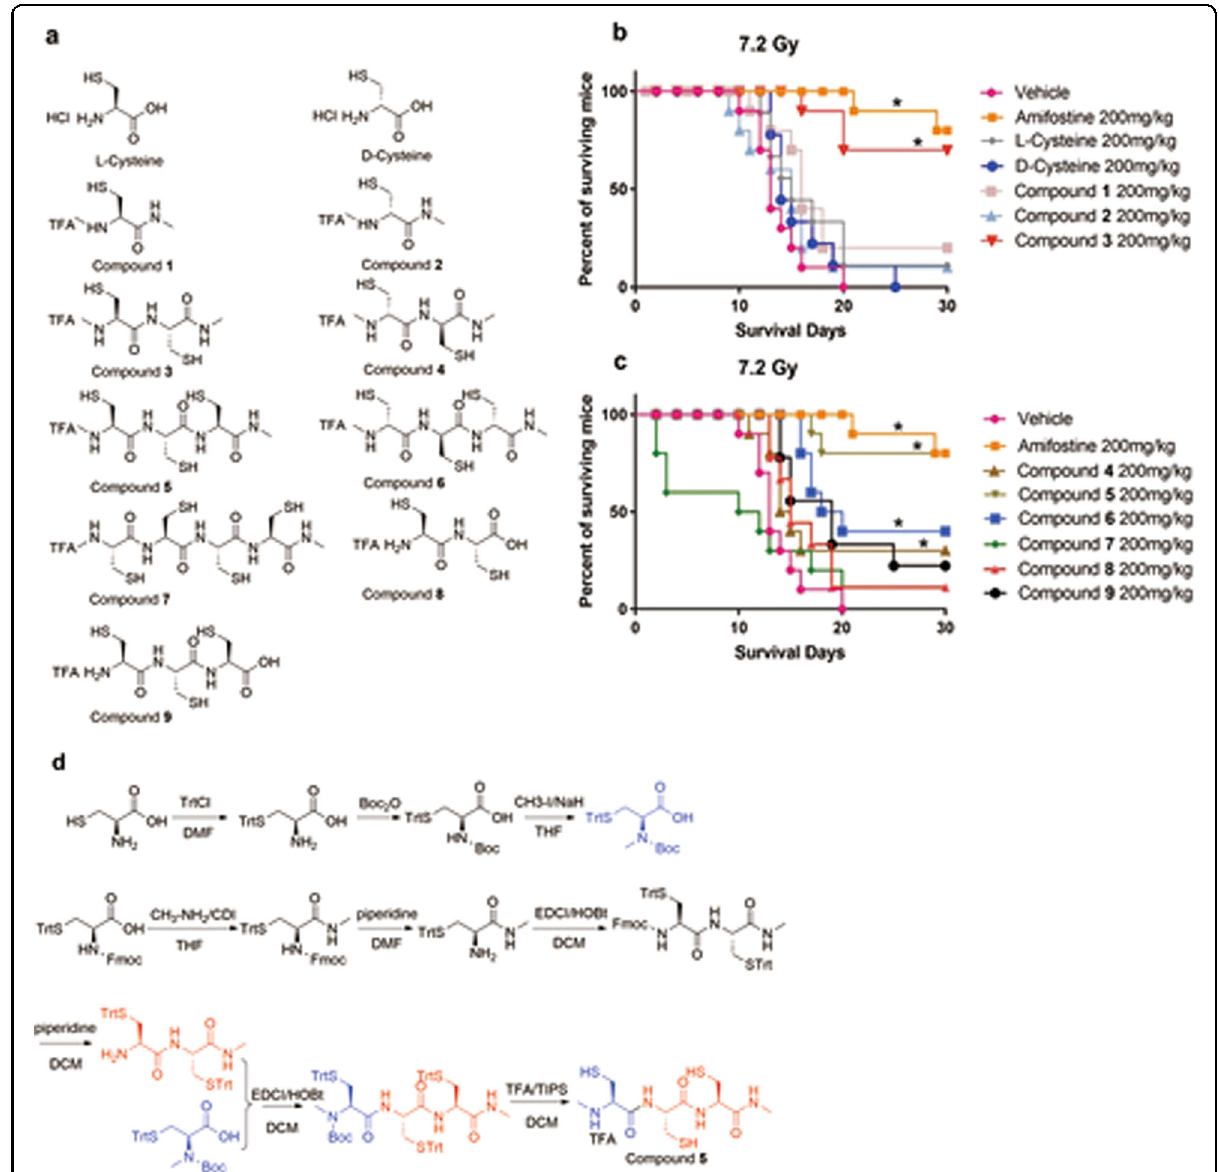
Fig. 1 Chemical structure of compounds and their 30-days survival rate after exposed to lethal TBI in mice. a Chemical structure of cysteine, derivatives, and new compounds 1 – 9 ; b Survival rate of irradiated mice treated with L -cysteine, D -cysteine, and compounds 1 – 3 . c Survival rate of irradiated mice treated with compounds 4 – 9 ; d Synthesis scheme of compound 5 ; * p < 0.05 vs 7.2 Gy, N = 10 in each